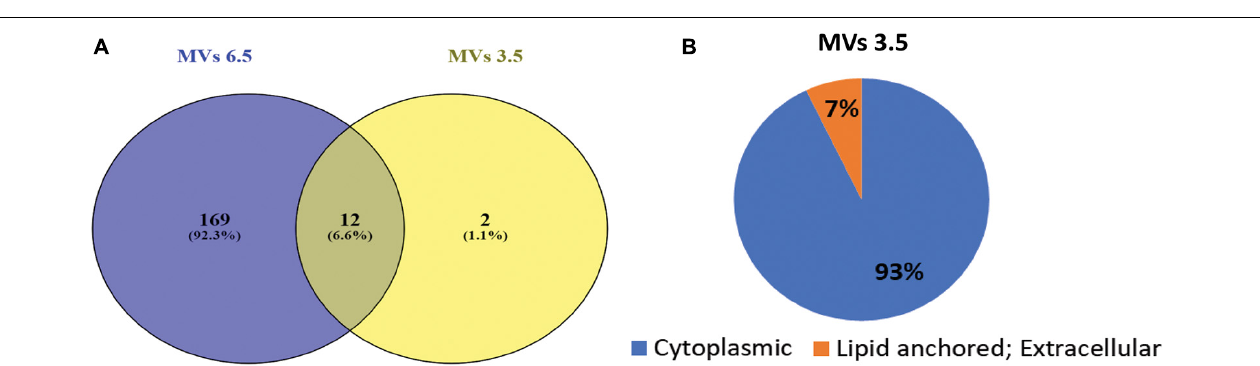
FIGURE 5 | Proteomic analysis of G. vaginalis ATCC 14019 MVs in acidic stress. (A) Venn diagram demonstrating proteins common to MVs at pH 6.5 (Shishpal et al., 2020) and pH 3.5. (B) Subcellular localization of proteins of G. vaginalis MVs at pH 3.5 predicted using Uniprot and Locate P